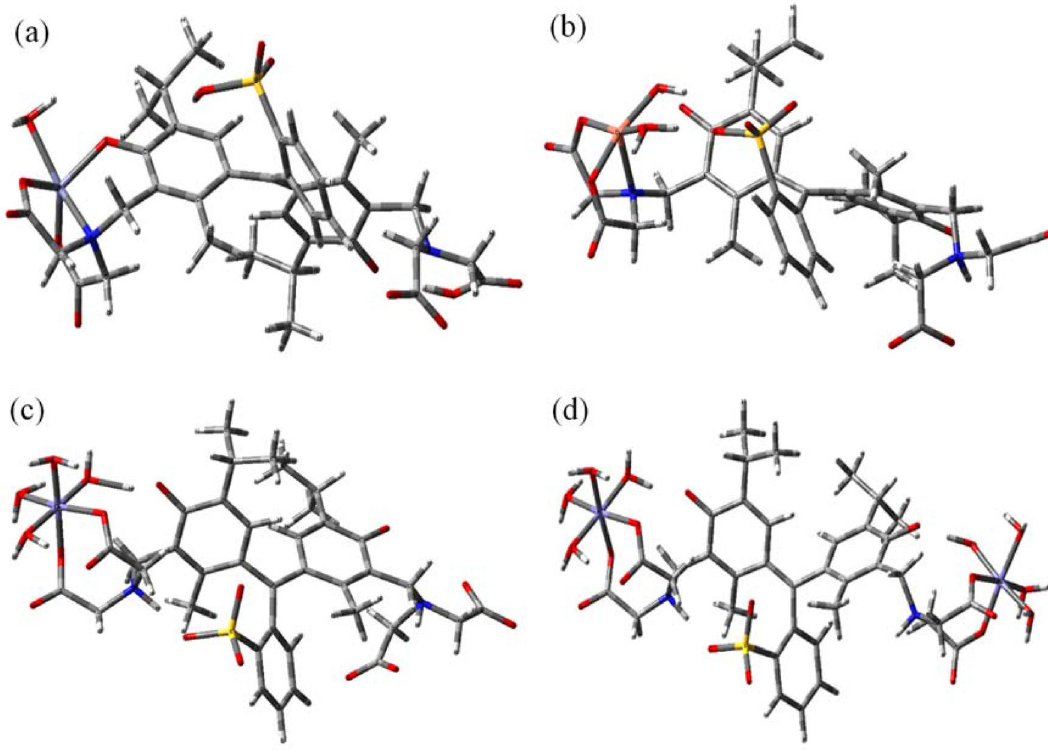
Figure 7. Optimized structures of the ( a ) Zn(MTB), ( b ) Cu(MTB), ( c ) Fe(MTB) and ( d ) Fe 2 (MTB)